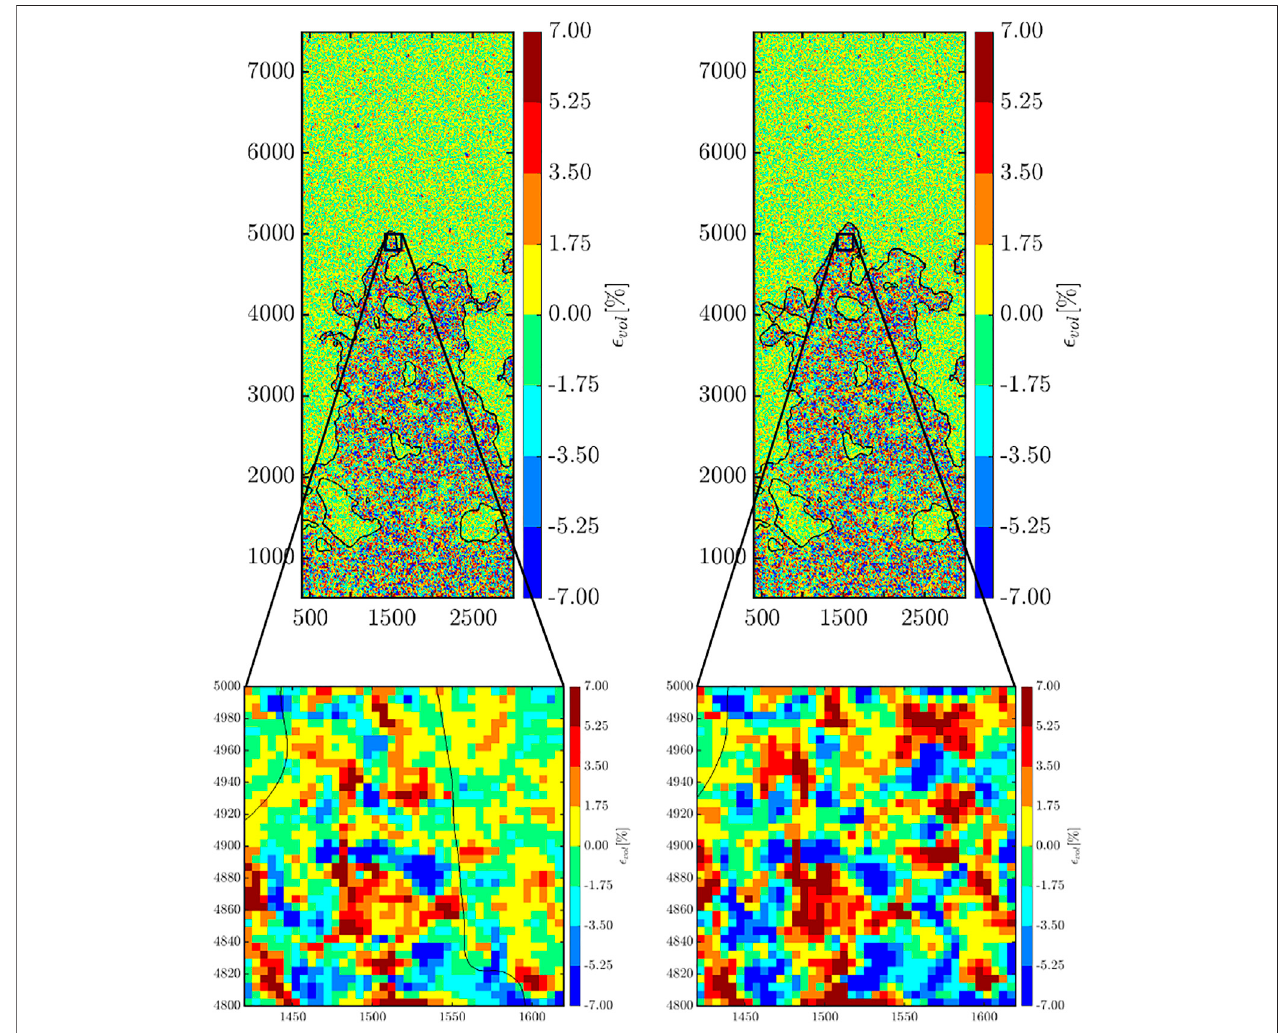
FIGURE8| Close-upwindowsonvolumetricstrainmapsatthetipofthe fi ngerat t i and t i +0,033 s duringthetest(1),obtainedusingameshsizeof fi vepixelsanda Tikhonov regularization of 15 pixels.